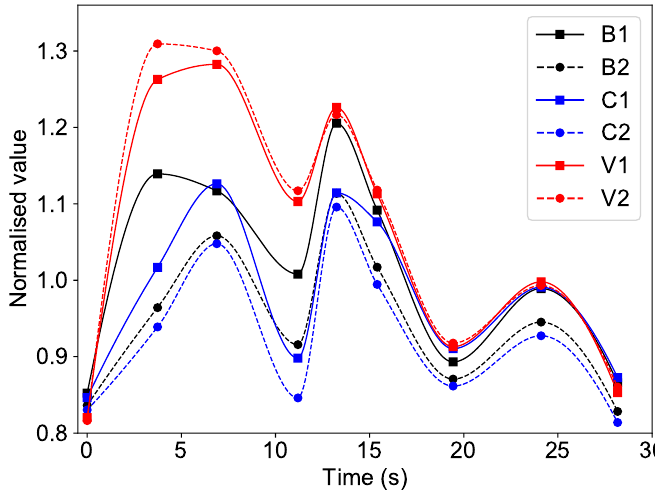
Figure 8. Pressure change at the monitoring